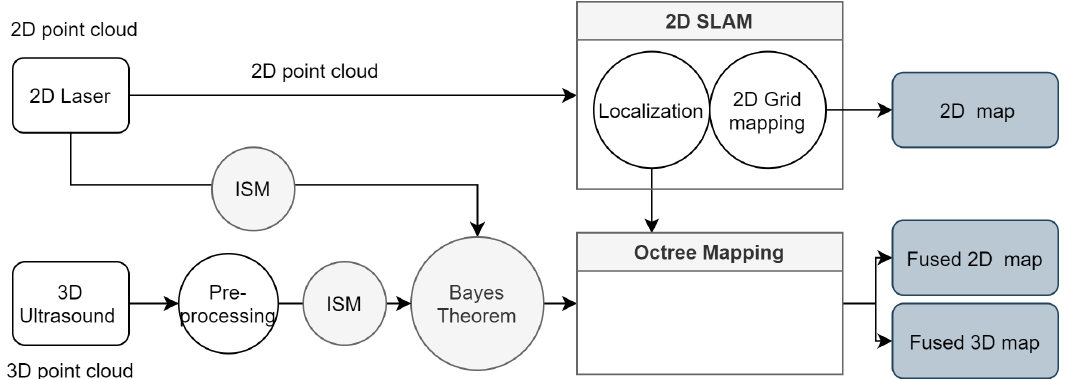
Figure 11. Data flow